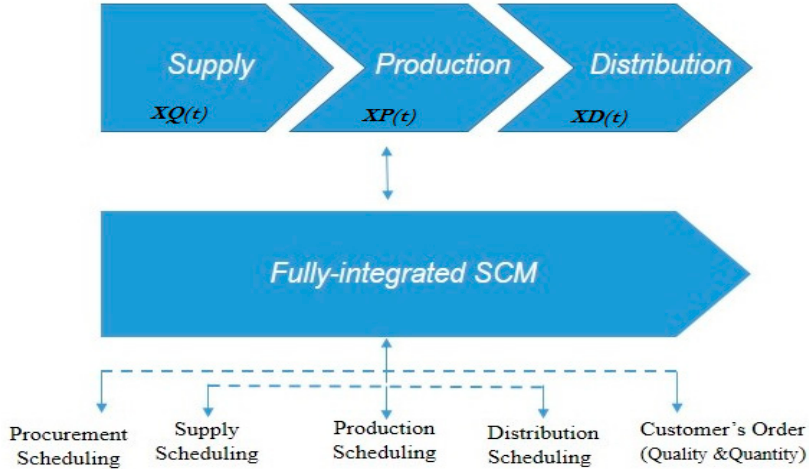
Figure 1. The fully integrated supply, production and distribution Model. Input supply X Q ( t ), Production X P ( t ) and Distribution X D ( t )